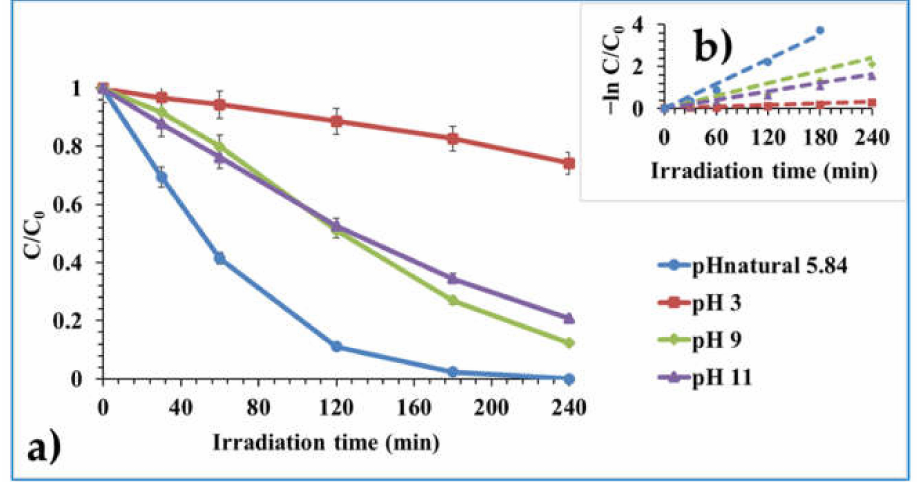
Figure 9. ( a ) Effect of pH on the photocatalytic degradation performance of 1/g/L Mo/SynTiO 2 over 5 mg/L initial CBZ concentration under 365 nm irradiation, and ( b ) their corresponding photocatalytic degradation rate constant